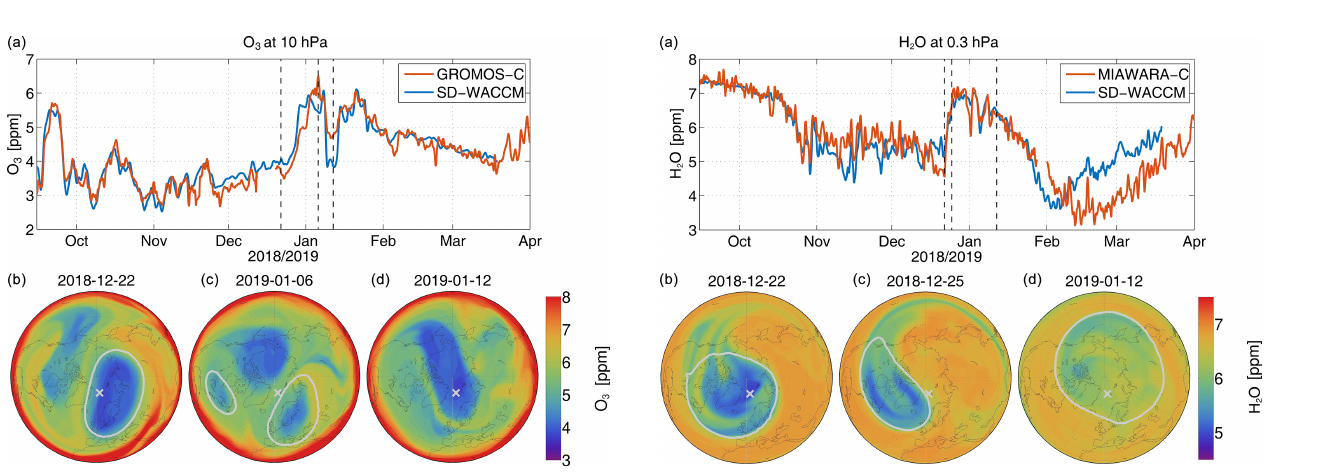
Figure 8. GROMOS-C and SD-WACCM ozone VMR time series at 10hPa smoothed by a 1d running mean (a) and SD-WACCM ozone VMR at 10hPa in the Northern Hemisphere (b–d) for three dates which are indicated with dashed lines in panel (a) . In the NH plots (b–d) the location of Ny-Ålesund and the polar vortex edge are indicated in grey.